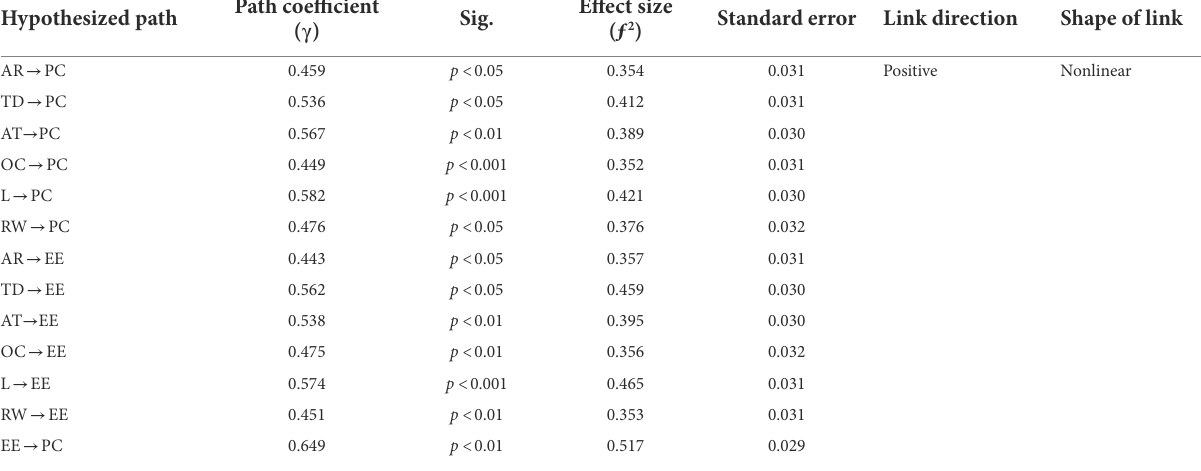
TABLE 5 Standardized path coefficients for the proposed model.